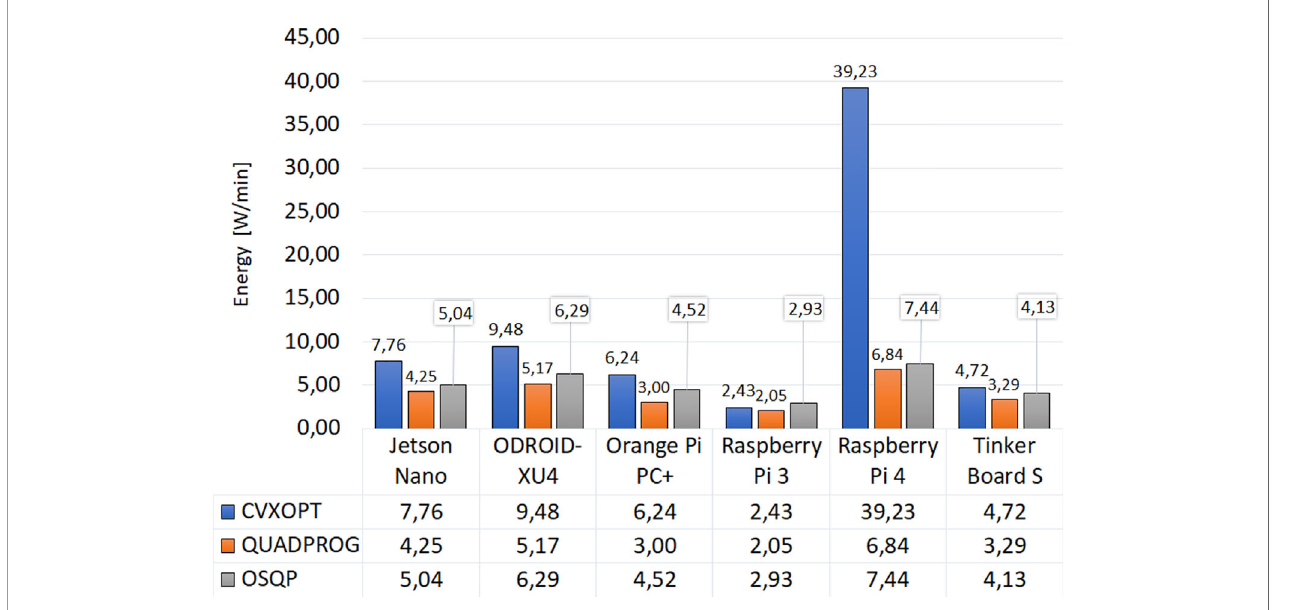
FIGURE 4 | Consumed energy of each embedded system per package.